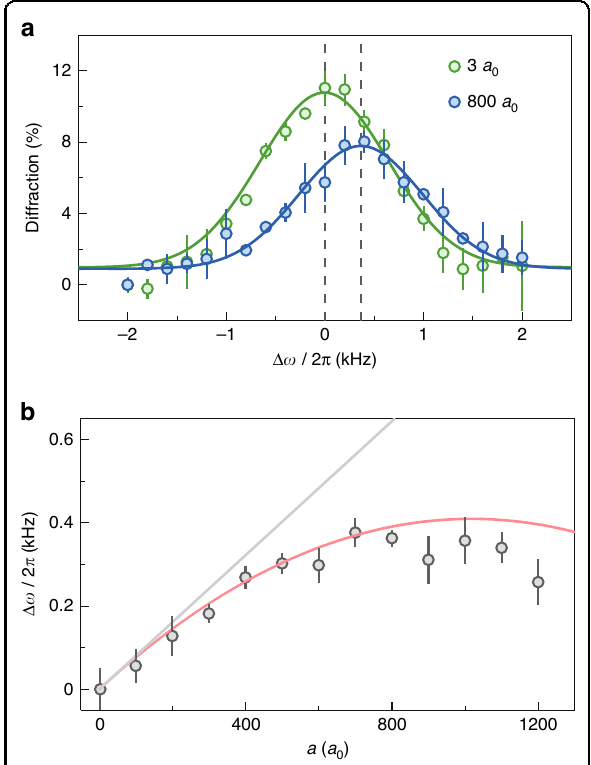
Fig. 2 Two-photon Bragg spectra of BEC with tunable interaction. a Two-photon Bragg spectra for two different scattering lengths (in unit of Bohr radius of a 0 ). Fraction of atomic BEC diffracted into the momentum state p = 2 ħ k as a function of the frequency shift Δ ω , which is referenced to the noninteracting free-particle energy 4 E R / ħ , after 1 ms Bragg pulse. The resonance shift is determined by a Gaussian fi t to the data (solid lines). Error bars denote the standard errors. b Dependence of the frequency shift Δ ω extracted from the fi tting in ( a ) on the scattering length a . The grey solid line is obtained by the Bogoliubov theory, and the red solid line is the prediction based on the Feynman-Tan relation in Eq. (4). The averaged density of ρ = 1.6 × 10 13 /cm 3 is taken in the theoretical calculation. Error bars denote the fi tting